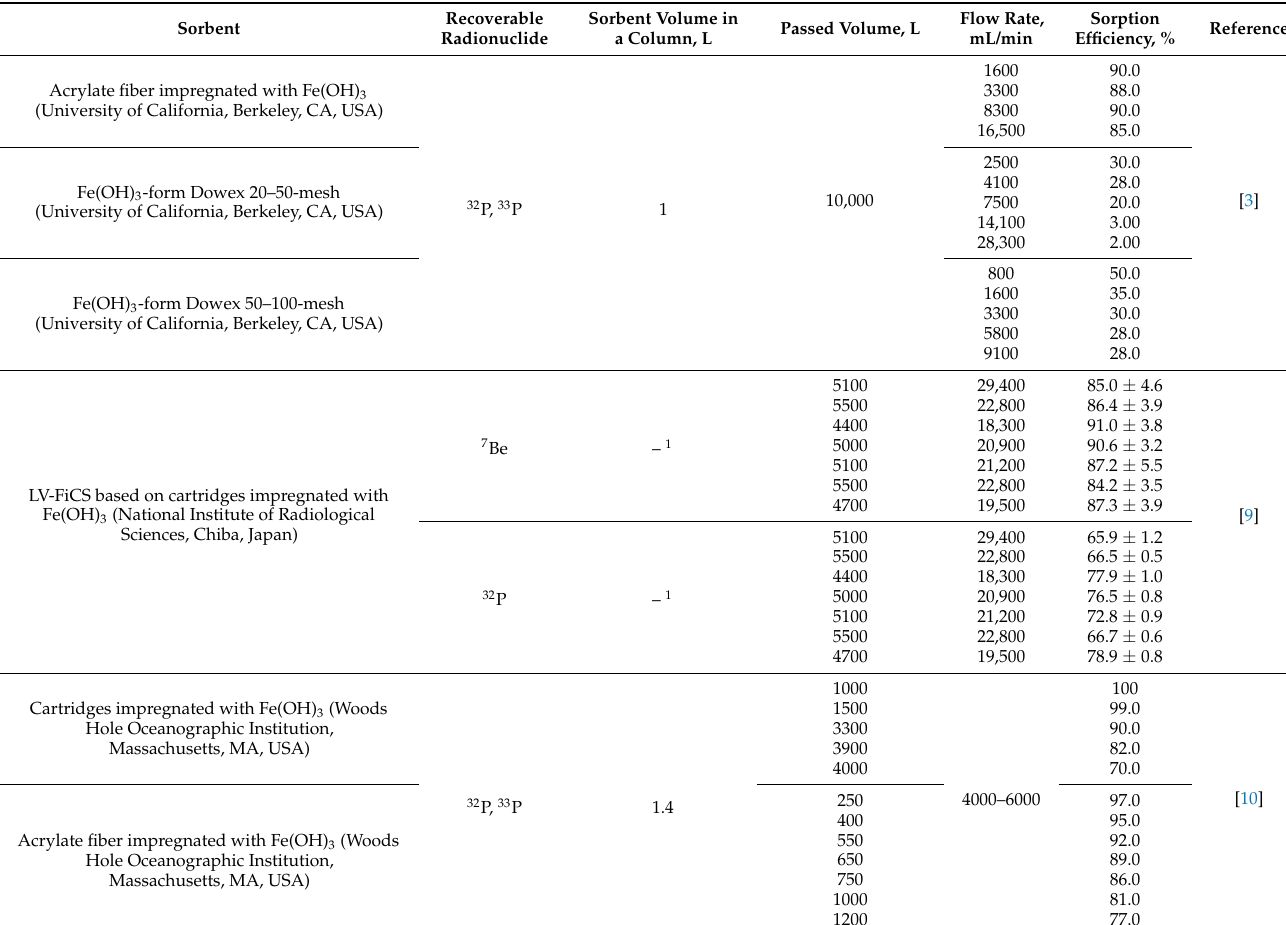
Table 1. Sorption parameters of natural and cosmogenic radionuclides from seawater under dynamic